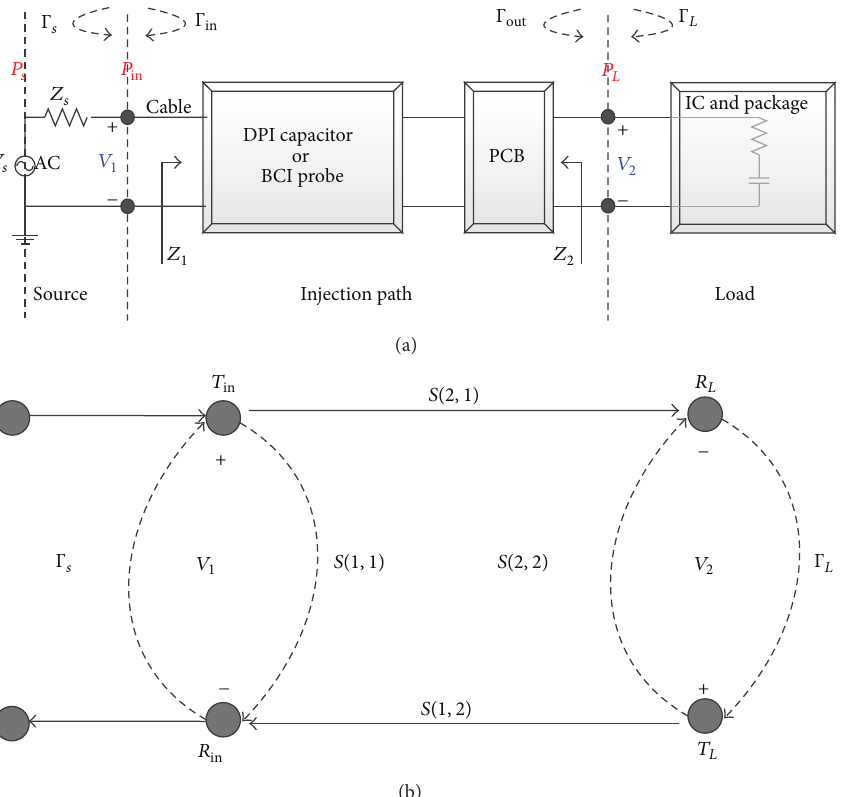
Figure 2: (a) The 2-port circuit network diagram of the BCI test. (b) The flow of RF power with the scattering parameters and the reflection